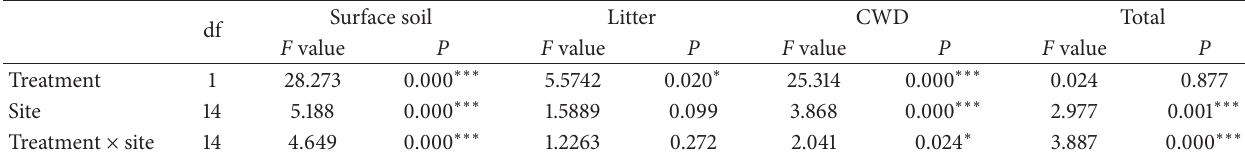
Table 1: ANOVA of soil, litter, and coarse woody debris (CWD) carbon mass per area by treatment. Surface soil df